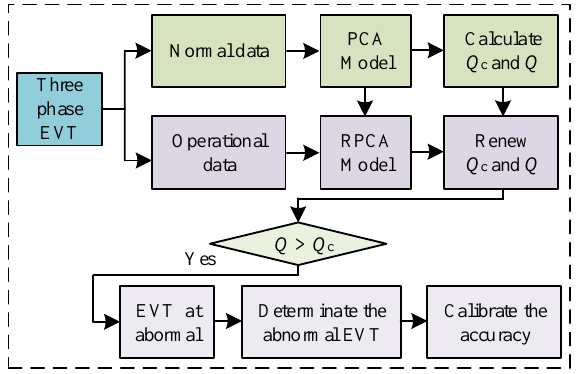
Figure 2. Proposed online evaluation of the EVT.